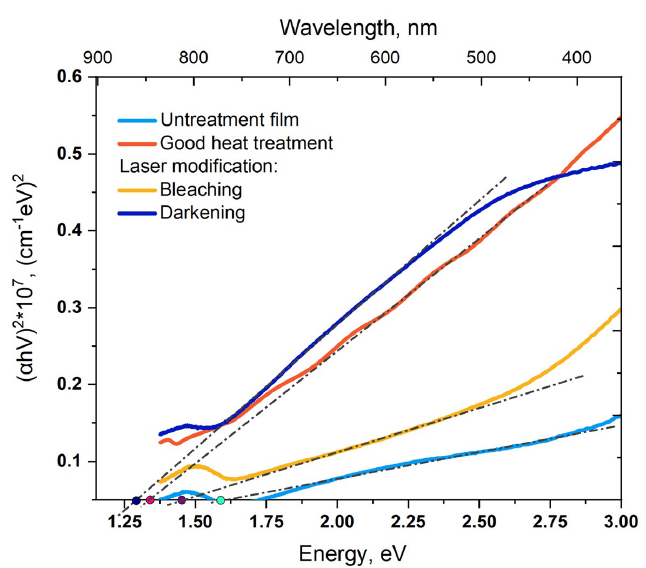
Figure 12. Determination of the optical band gap Eg before and after modification of PbSe films: untreated (light blue curve), heat treatment (red curve), bleaching mode (yellow curve), darkening mode (blue curve).